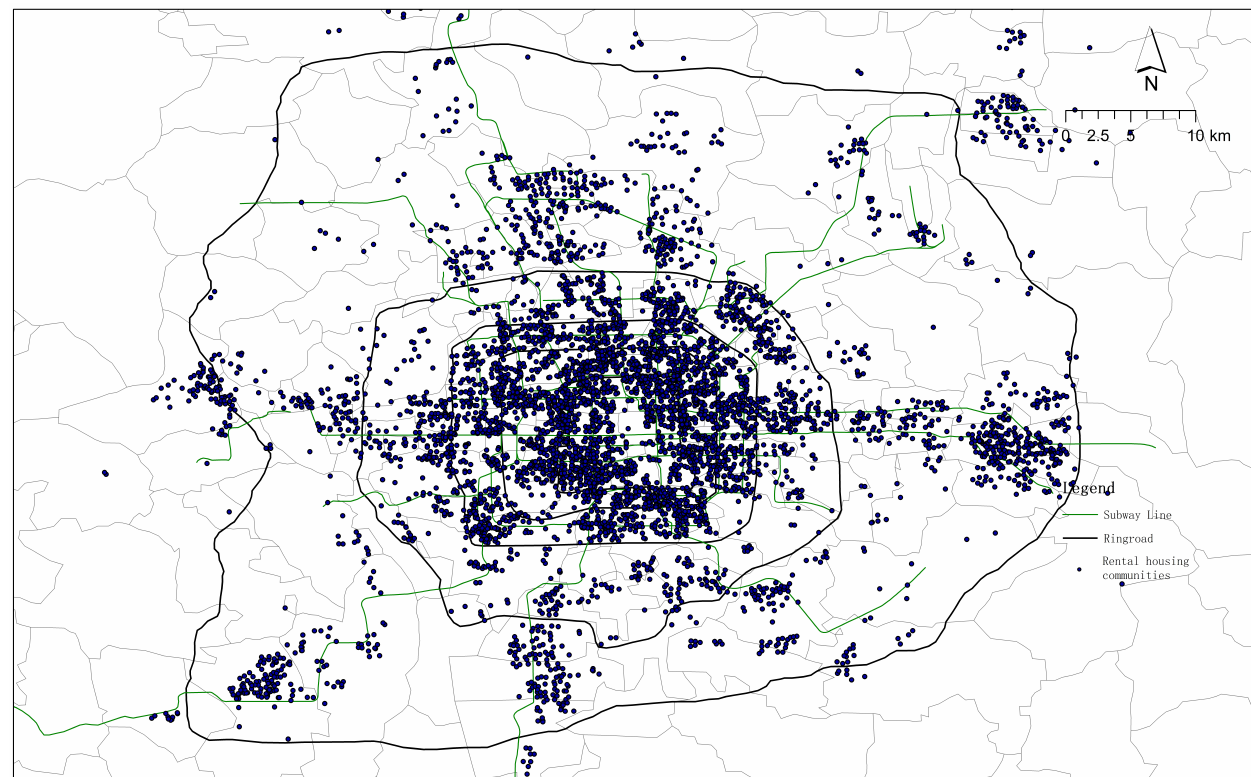
Figure 1. Distribution of market-leased communities in